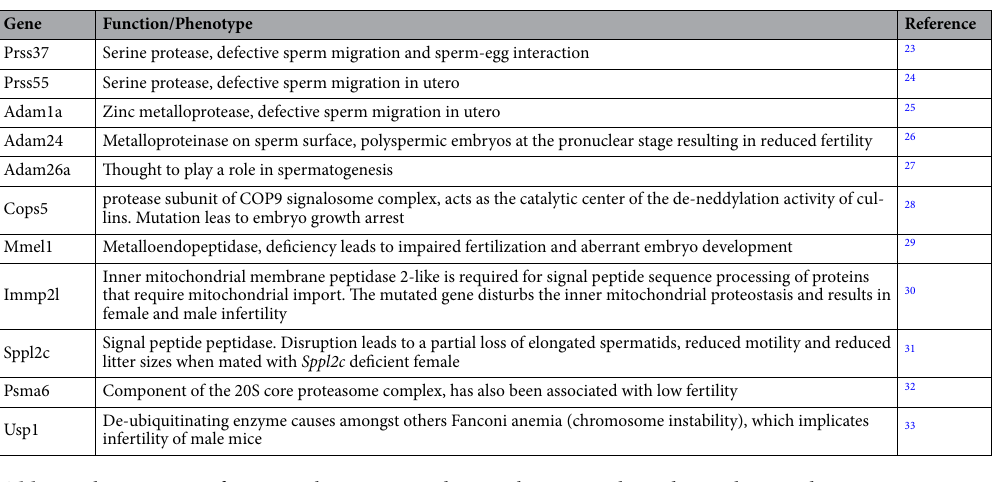
Table 2. Shows 11 out of 43 proteolysis associated genes that are implicated in male